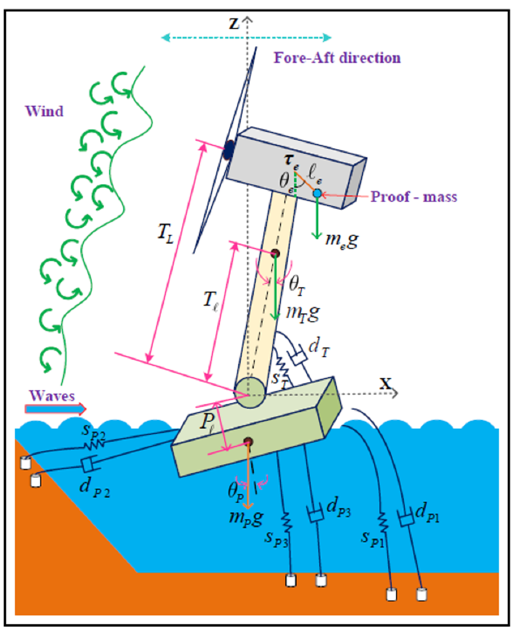
Figure 1. Barge ‐ type TORA ‐ based 5DOF OFWT model. Figure 1. Barge-type TORA-based 5DOF OFWT